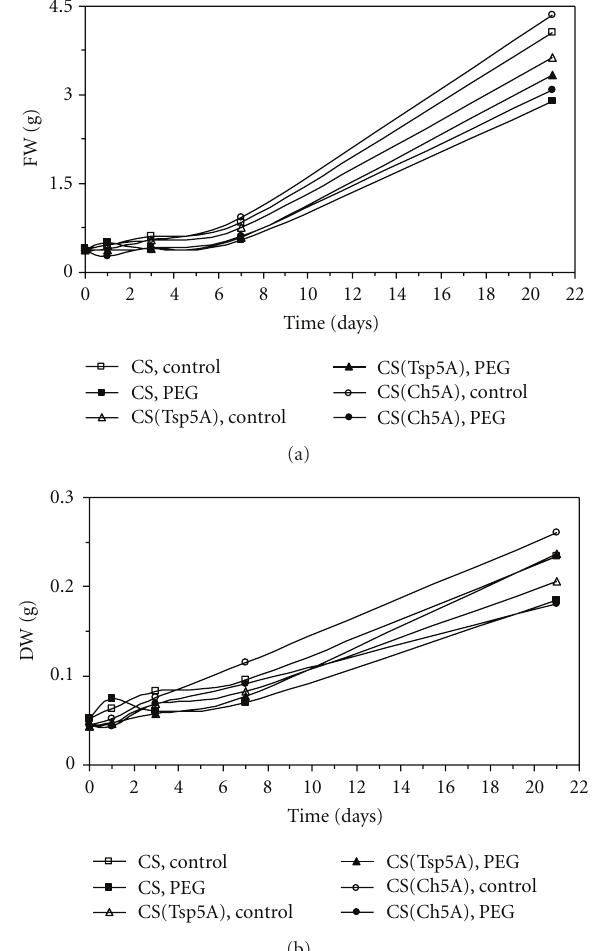
Figure 1: E ff ect of osmotic stress on fresh ((a); significant di ff erence (SD): 0.612) and dry weight ((b); SD: 0.065). The time course of changes was compared under control and stress (15% PEG) conditions in the freezing-sensitive CS and CS(Tsp5A) and the freezing-tolerant CS(Ch5A) wheat genotypes. The standard deviations of the data were below 10% in each case (not shown on the graphs because of the better